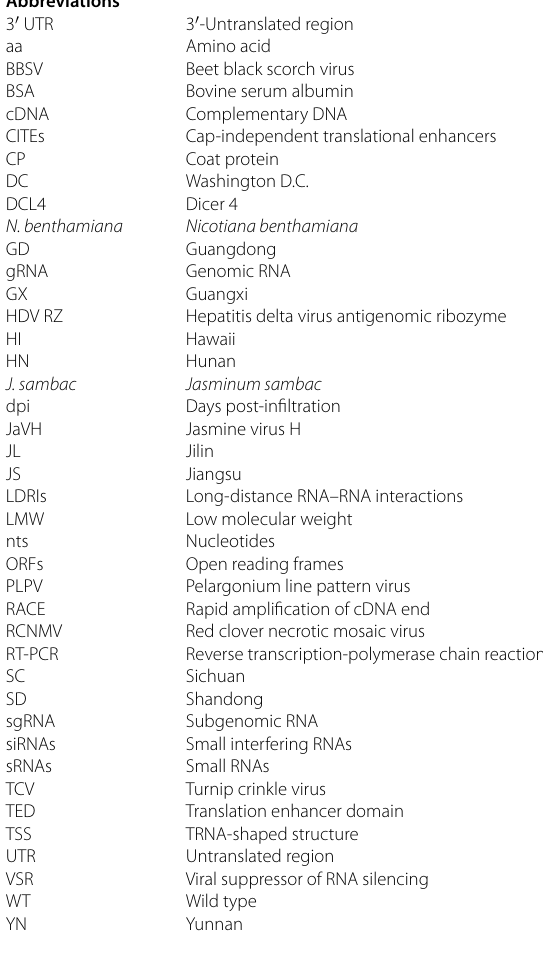
Figure S2. Putative secondary structure predicted in JaVH isolates and recombinant viruses. Additional file 2: Table S1. Primers used in this